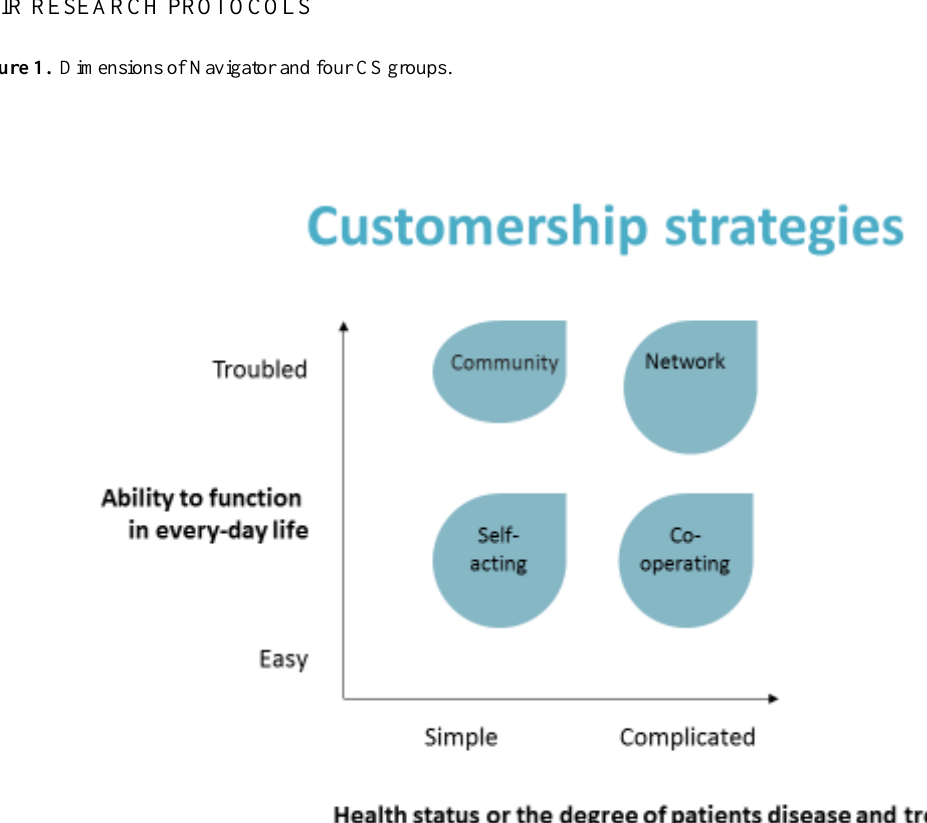
Figure 1. Dimensions of Navigator and four CS